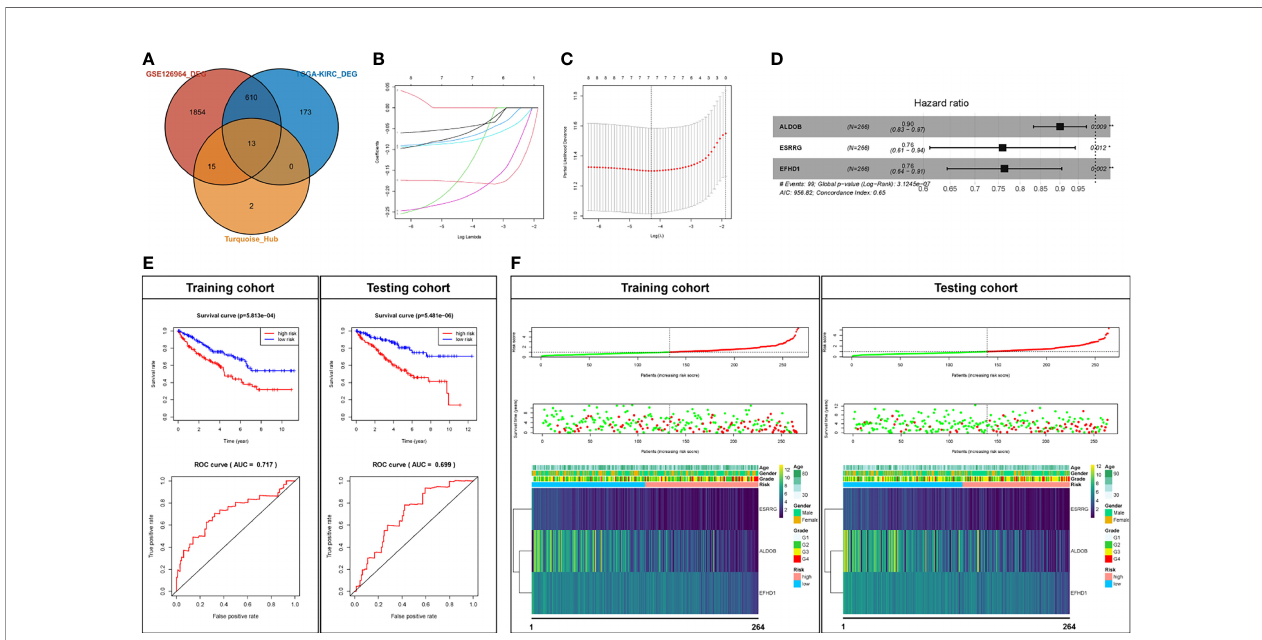
FIGURE 4 | Prognostic analysis of the key genes. (A) Key genes belonging to both the hub genes and DEGs of the GSE126964 and TCGA-KIRC datasets. (B , C) LASSO regression complexity was controlled by lambda using the glmnet R package. (D) The multivariate analysis of risk factors in ccRCC. (E) Overall survival and ROC analysis between high-risk score and low-risk score groups in the training cohort and testing cohort. (F) The overall survival strati fi ed by the high- and low- risk score groups was plotted for the training cohort and testing cohort. Detailed risk scores, survival information, and heat maps of gene expression are also included for each dataset. *p < 0.05; **p < 0.01; DEG, differentially expressed gene; TCGA-KIRC, The Cancer Genome Atlas Kidney Renal Clear Cell Carcinoma; ROC, receiver operating characteristic; AUC, area under the curve; ccRCC, clear cell renal cell carcinoma; LASSO, least absolute shrinkage and selection operator.